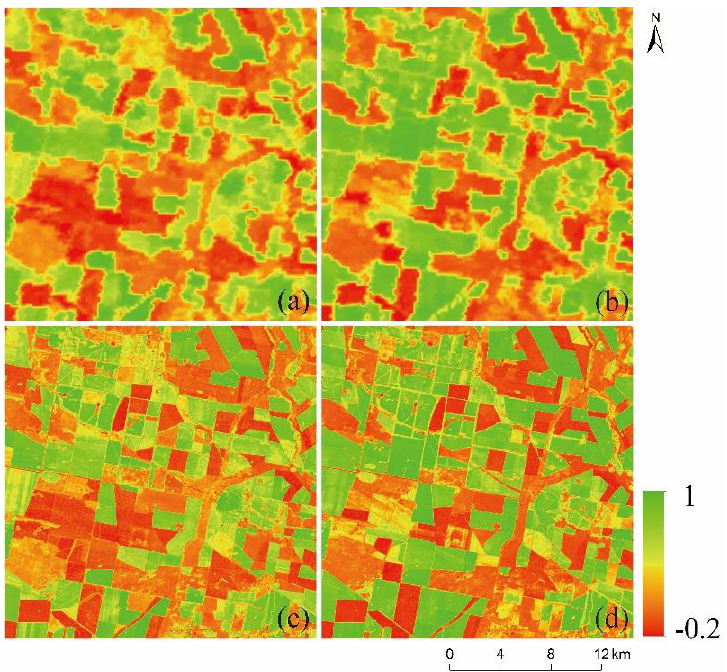
Figure 3. Testing datasets of cultivated land areas. ( a , b ). MODIS_NDVI on 5 July and 22 August 2004; ( c , d ). Landsat_NDVI on 5 July and 22 August 2004.